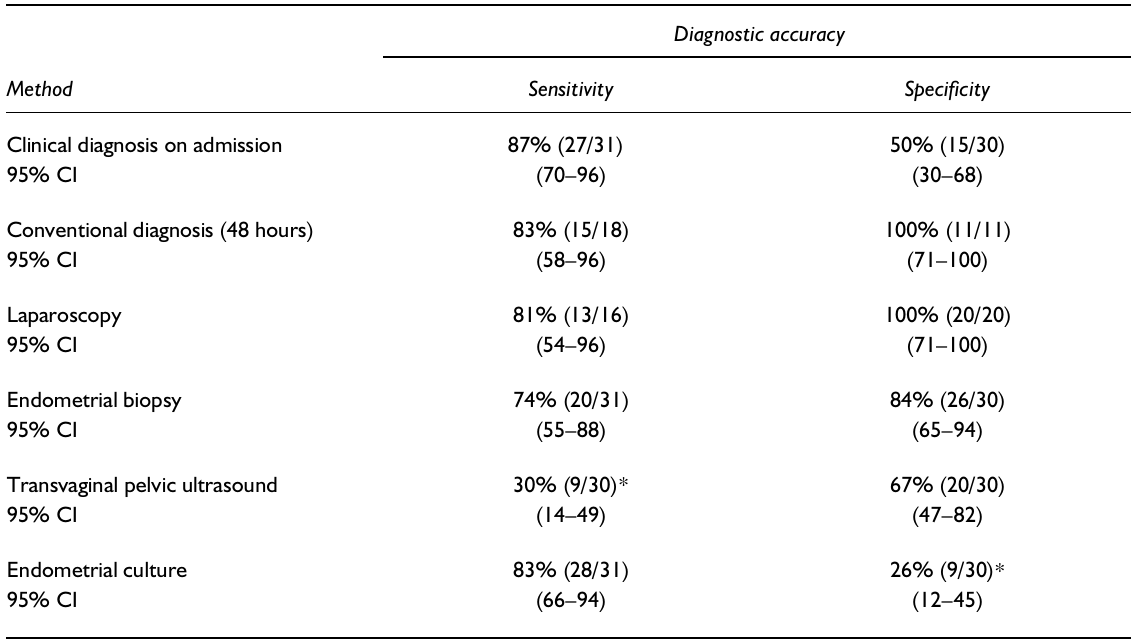
Table 4 Sensitivity analysis of operative characteristics for five different techniques in the diagnosis of pelvic inflammatory disease in patients having non-specific lower abdominal pain at the Instituto Materno Infantil, Bogotá between 1998 and